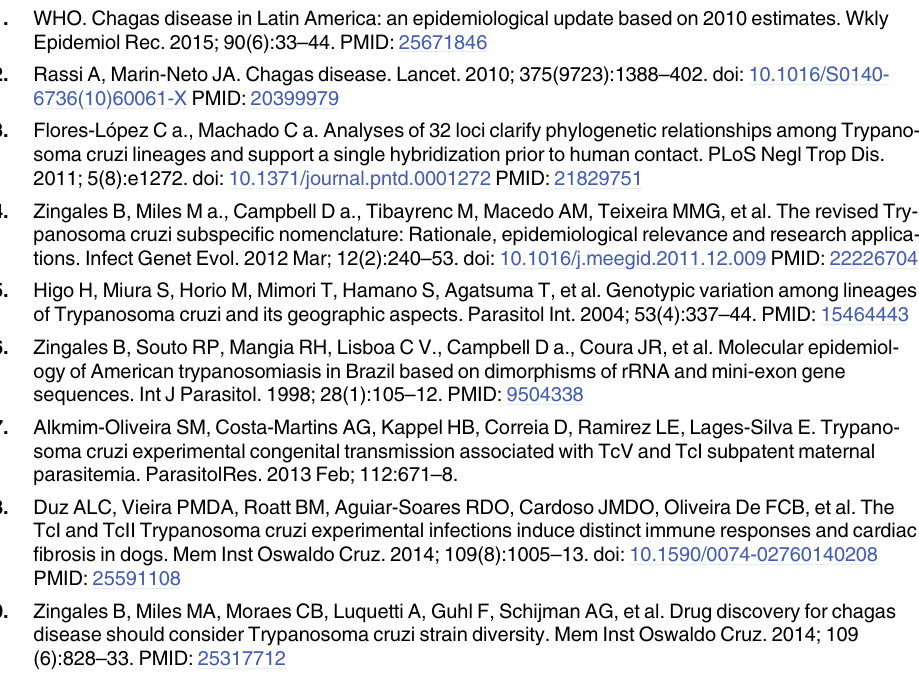
S6 Table. Core orthologs between T . cruzi Sylvio strain and Y strain. Final set of orthologs produced for this work. Briefly, Version 8.0 genome fasta files for T . cruzi Sylvio strain and T . cruzi CL Brener strain (Esmeraldo-like haplotype) were aligned using the FASTA program ggsearch36, which does a global:global alignment. Reciprocal best hits were then further refined by removing genes in the four largest multi-gene families (MASP, trans-sialidase, retroposon hot-spot and dispersed gene family protein) and then selecting genes which have only a single reciprocal best